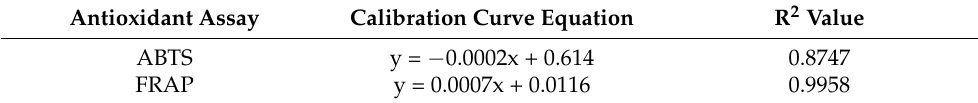
Table 8. Equations of calibration curves for Trolox standard used for FRAP and ABTS assay. Antioxidant